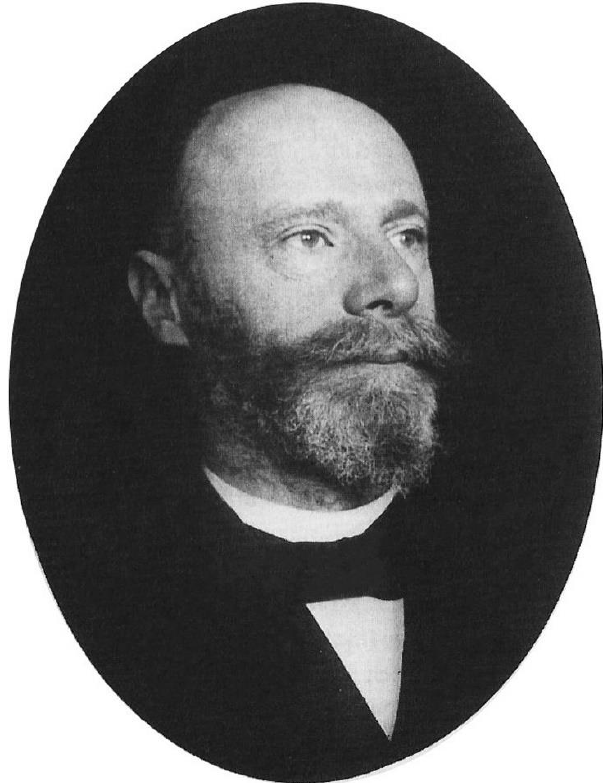
Figure 2 : Willem Einthoven